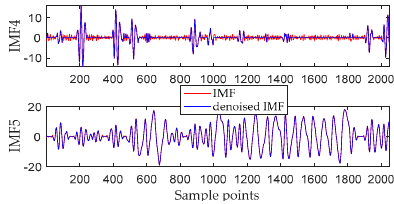
Figure 8. IMF4 and IMF5 before and after interval thresholding-based denoising.